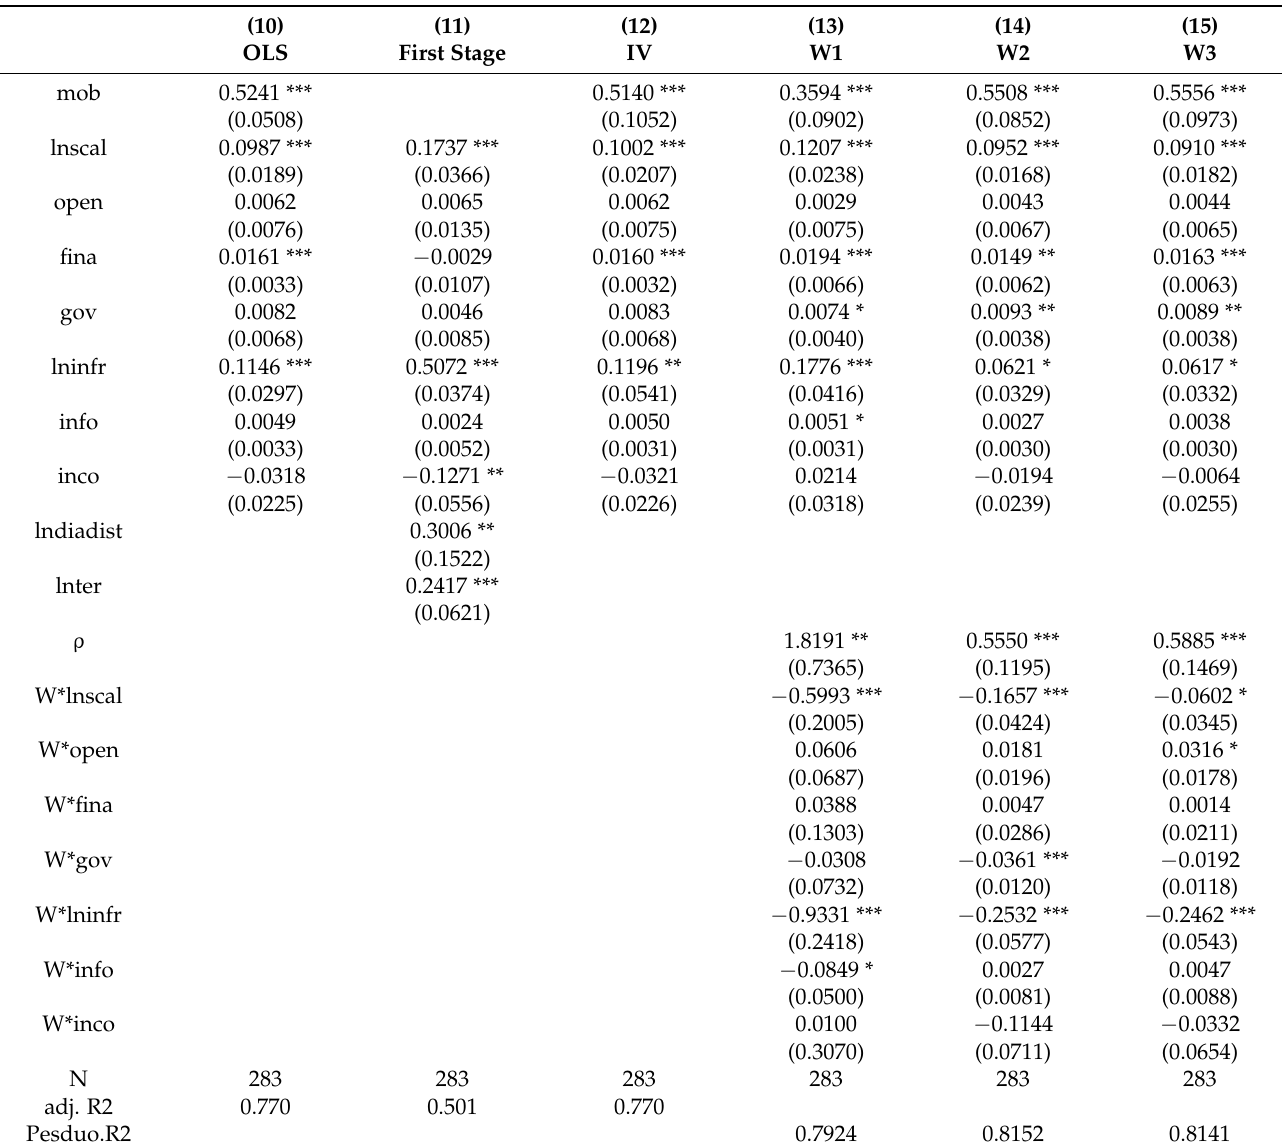
Table 5. Results of instrumental variable